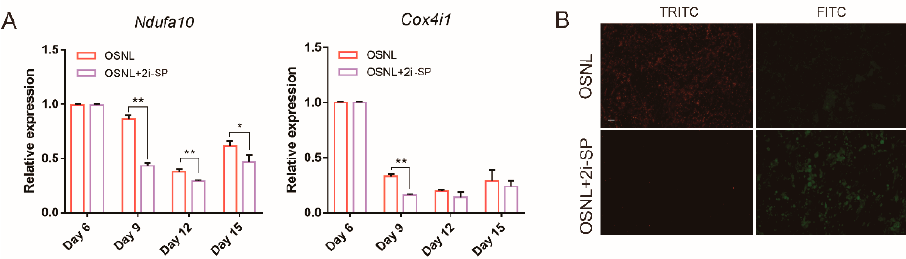
Figure 7. 2i-SP inhibits oxidative phosphorylation to promote chicken iPSC formation. ( A ) qRT-PCR analysis of expression of genes encoding related enzymes in oxidative phosphorylation after adding 2i-SP. ( B ) Changes in cell mitochondrial membrane potential after adding 2i-SP detected by the JC-1 kit. When the mitochondrial membrane potential is high, JC-1 can form polymers and produce red fluorescence (~590 nm, TRITC). On the contrary, when the mitochondrial membrane potential is low, JC-1 is a monomer and produces green fluorescence (~525 nm; FITC). Scale bars = 100 µm. * Represents p < 0.05 and ** represents p < 0.01.